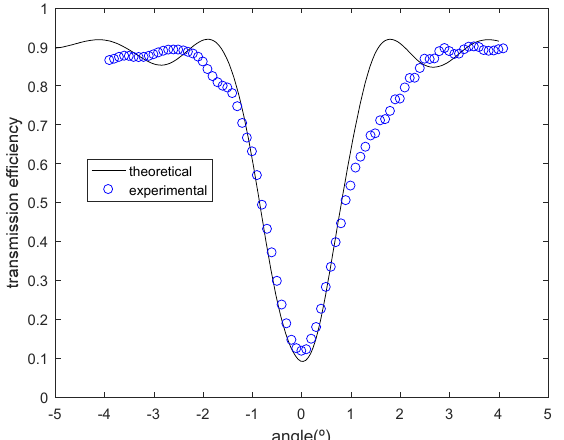
Figure 8. Transmission efficiency as a function of the angle made by the incident ray with respect to the normal of the sample for a slanted recorded grating of spatial frequency 1690 lines/mm.